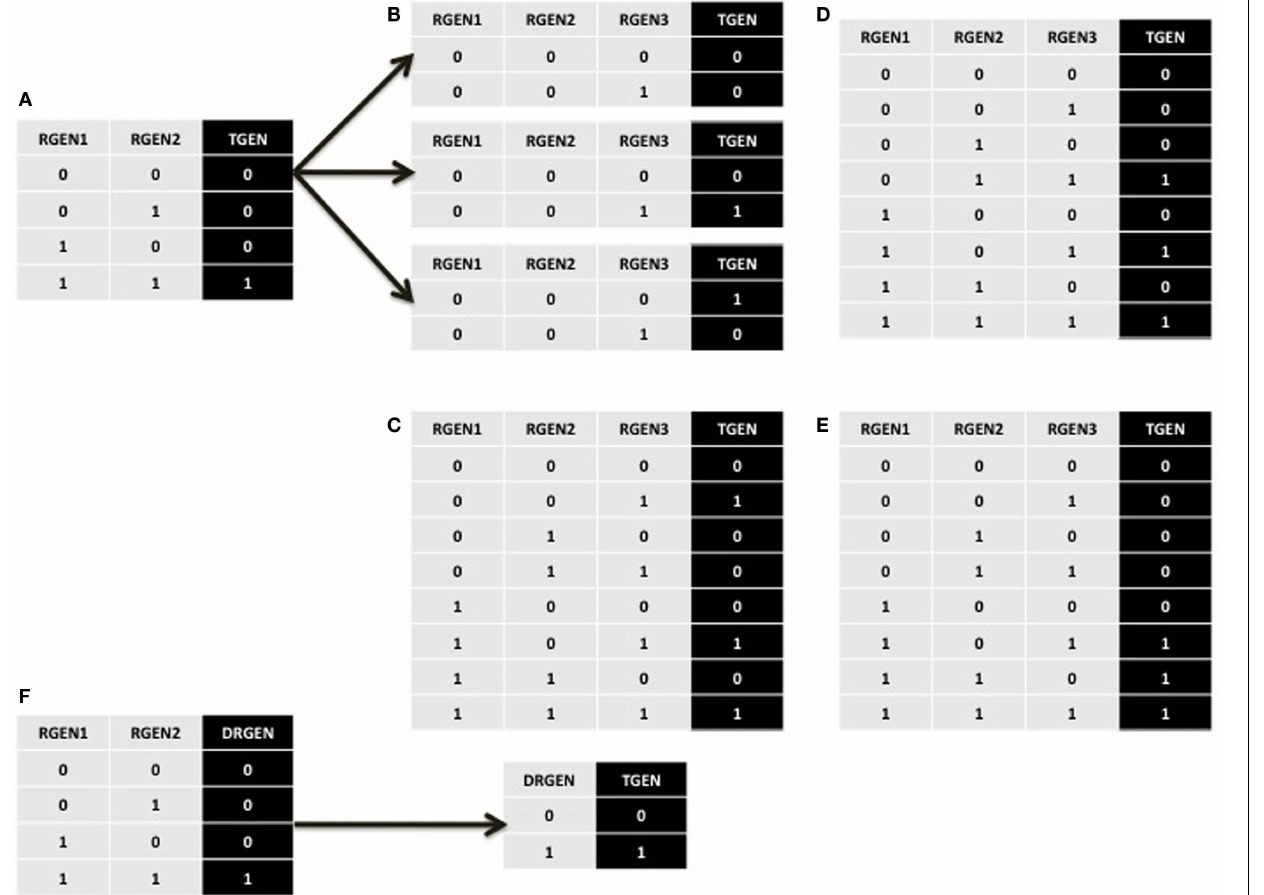
FIGUREA1 | Partial and complete truth tables describing the procedures explained in the main text . (A) Equivalent truth table for the logical statement “TGEN, RGEN1, AND RGEN2.” (B) The three possibilities for the first line of the truth table if a putative missing interaction is added. Each line describes one experiment. (C) A truth table where the original positive regulation ofTGEN by RGEN2 observed in (A) changes to a negative regulation. (D) A truth table where the original AND operator between RGEN1